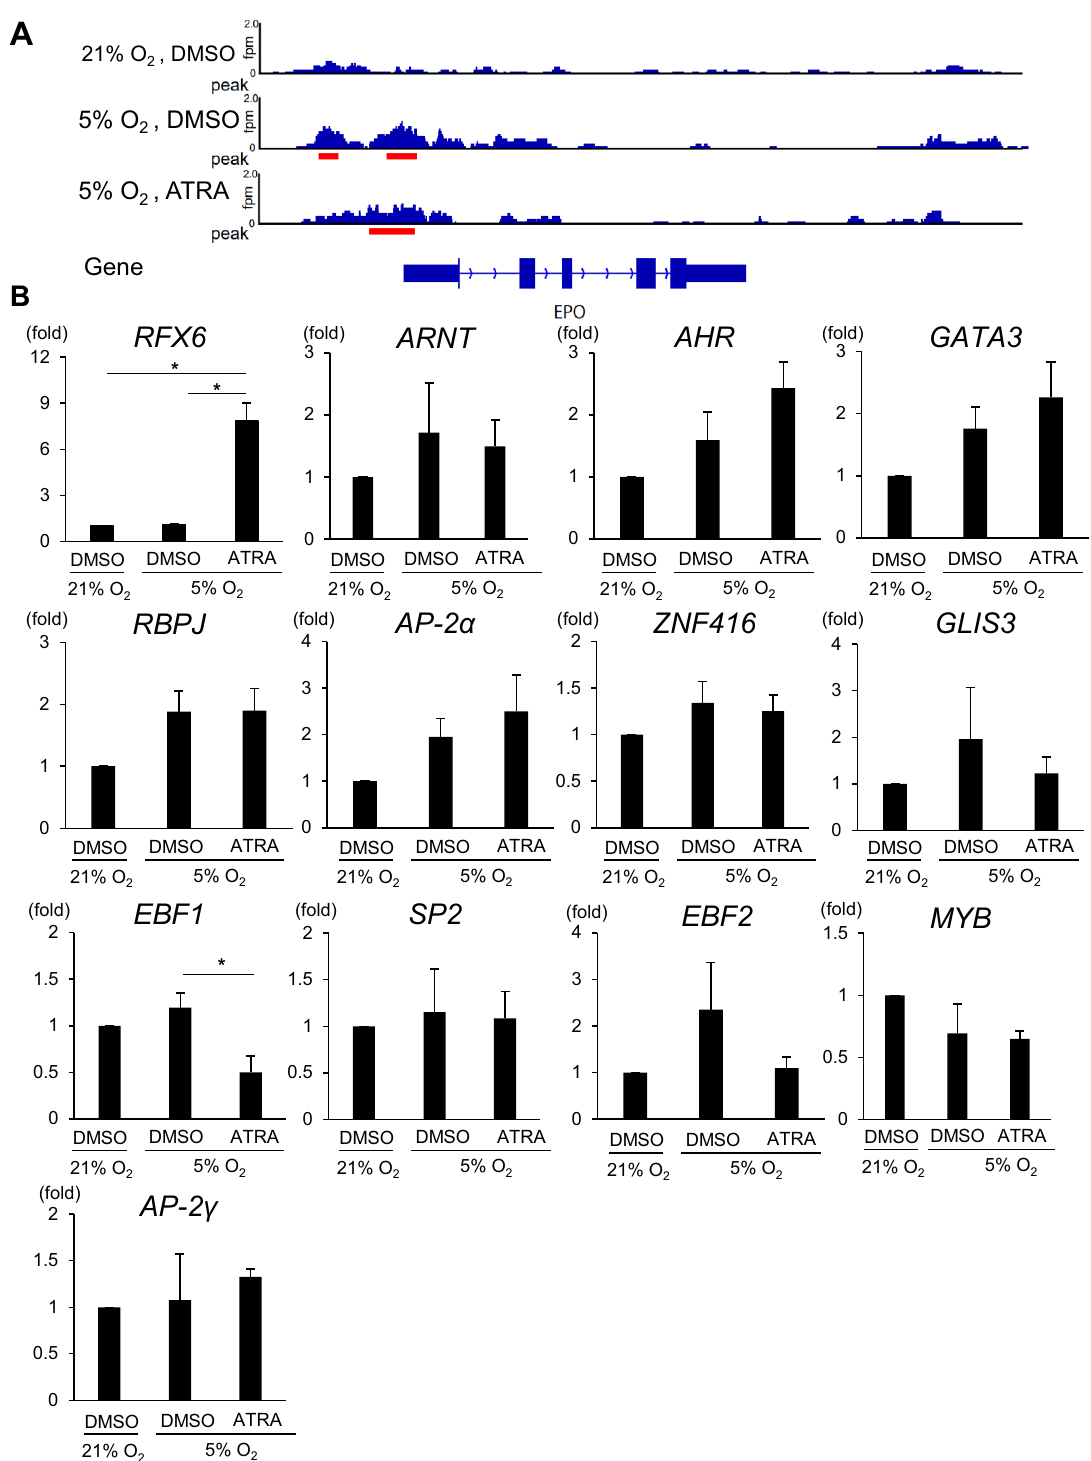
Figure 3. Chromatin structural changes near the EPO promoter in hiPSC-EPO cells. ( A ) Effects of hypoxic signals and ATRA treatment on chromatin formation in hiPSC-EPO cells evaluated by Assay for Transposase- Accessible Chromatin Sequencing (ATAC-seq). The ATAC-seq signals were visualized around the EPO TSS under normoxic (21% oxygen) or hypoxic conditions (5% oxygen) with DMSO treatment or under hypoxic condition with ATRA treatment. The y-axes of the ATAC-seq signals represent fragments per million mapped reads (fpm). Red lines indicate peak call regions. ( B ) qRT-PCR analysis of the mRNA expressions of the genes shown in Table 1. Each value was normalized to the samples treated with DMSO under normoxic conditions. The data from three independent experiments (n = 3) are represented as the means ± SEM. * p < 0.05 by one-way ANOVA with Bonferroni’s